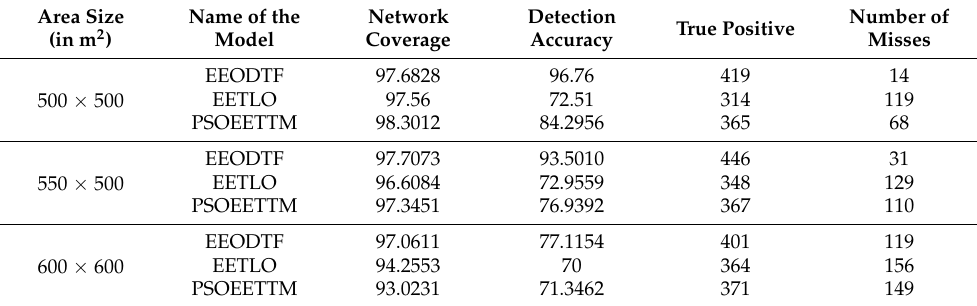
Table 10. Network coverage and detection accuracy for varying area